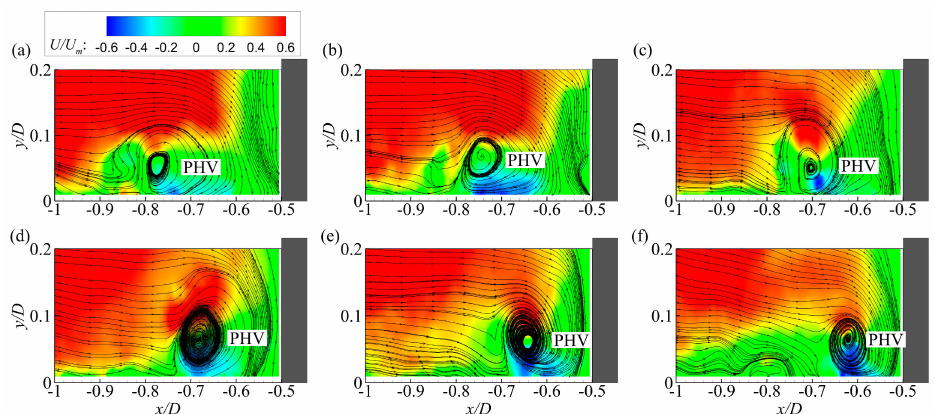
Figure 9. Sequence of instantaneous velocity fields illustrating the large-amplitude downstream motion of a PHV for case C13900. ( a ) t = 0; ( b ) t = 0.32 D / U m ; ( c ) t = 0.65 D / U m ; ( d ) t = 0.96 D / U m ; ( e ) t = 1.29 D / U m ; ( f ) t = 1.60 D / U